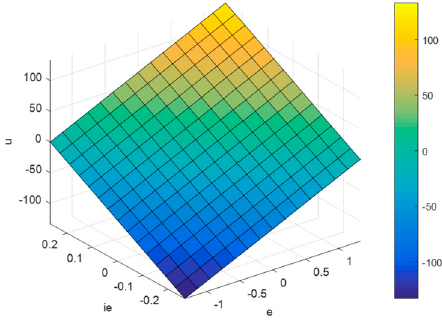
(cid:82) e ( t ) = 0.266).